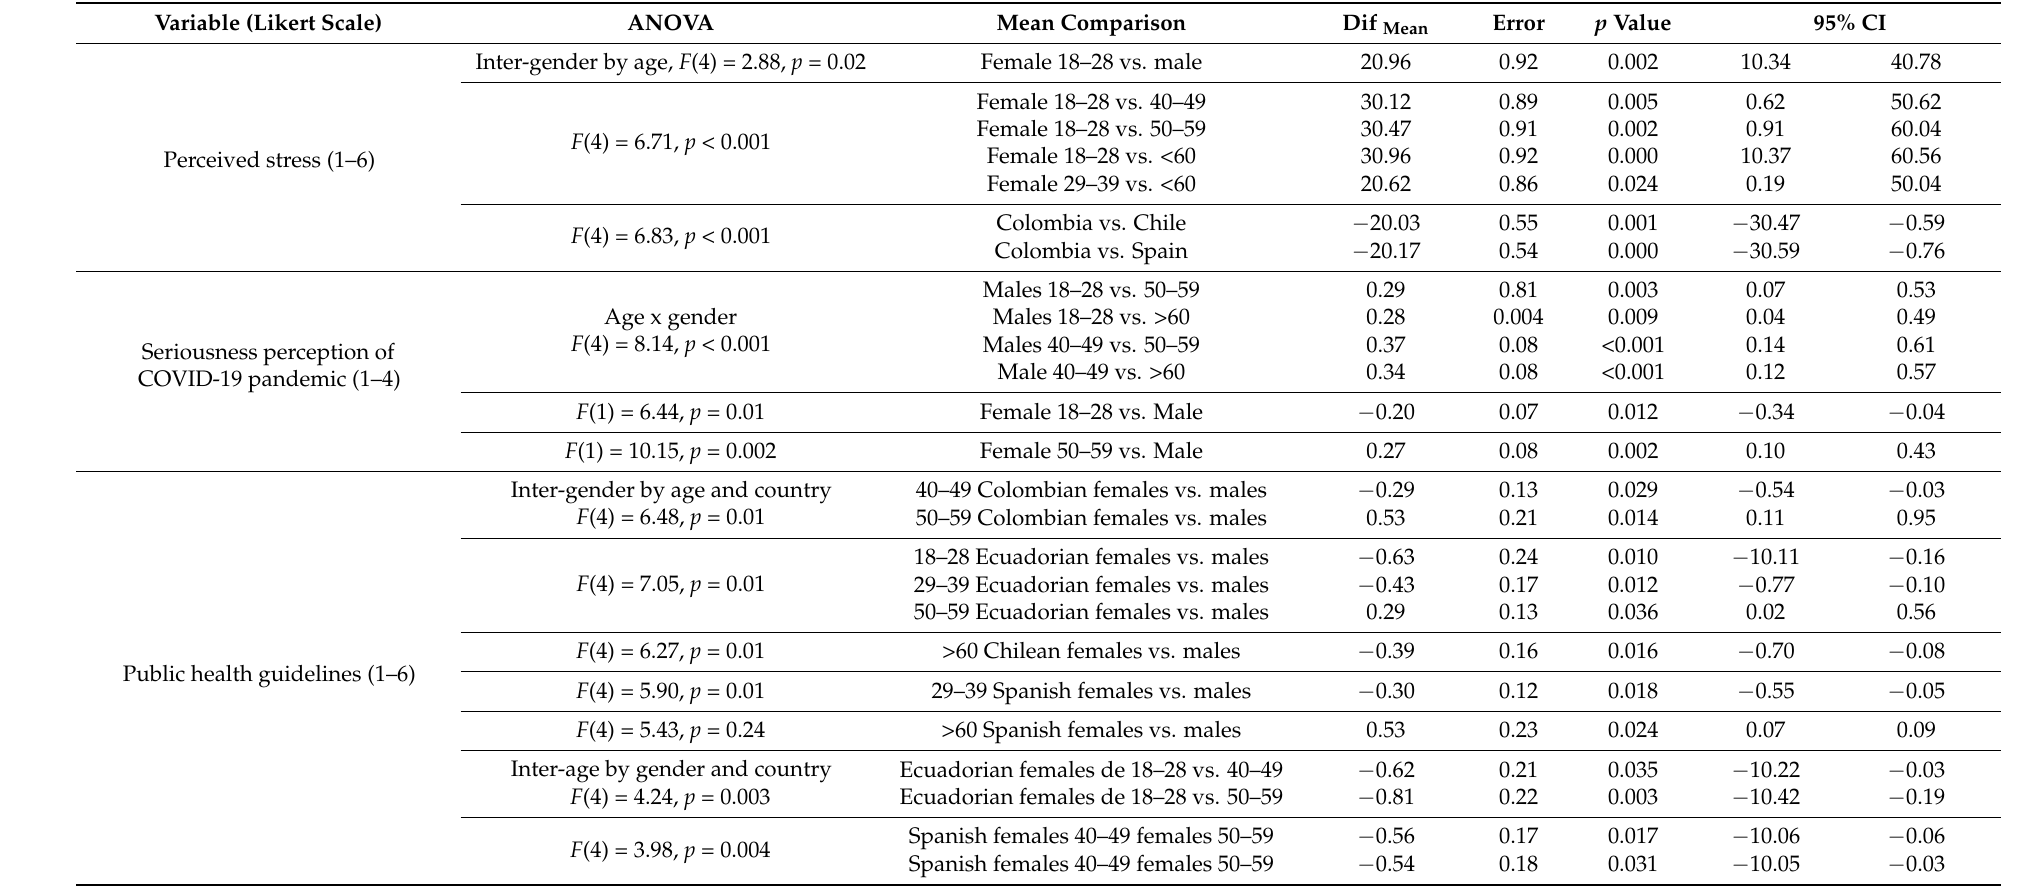
Table 2. ANOVA’s for pair means comparison of main variables